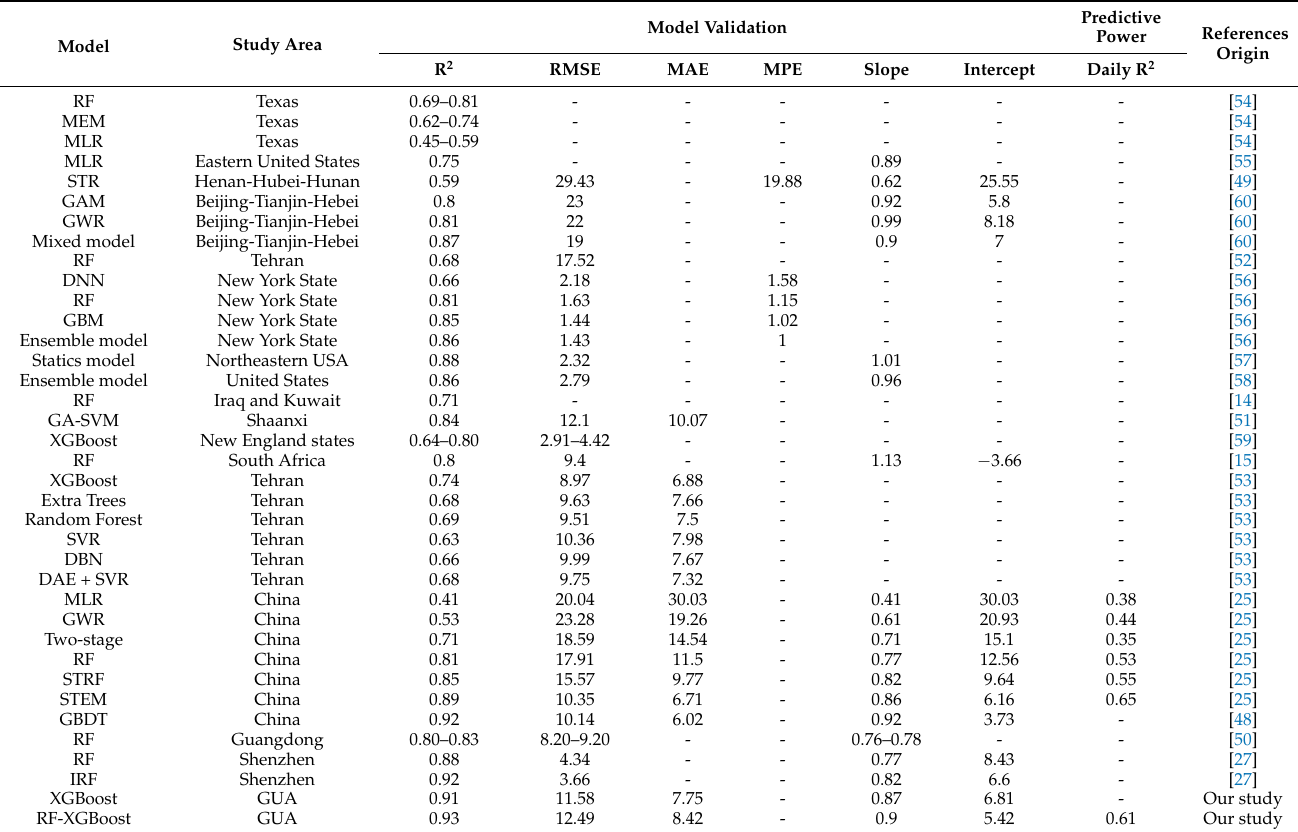
Table 3. A comparison of model performance between RF-XGBoost and other